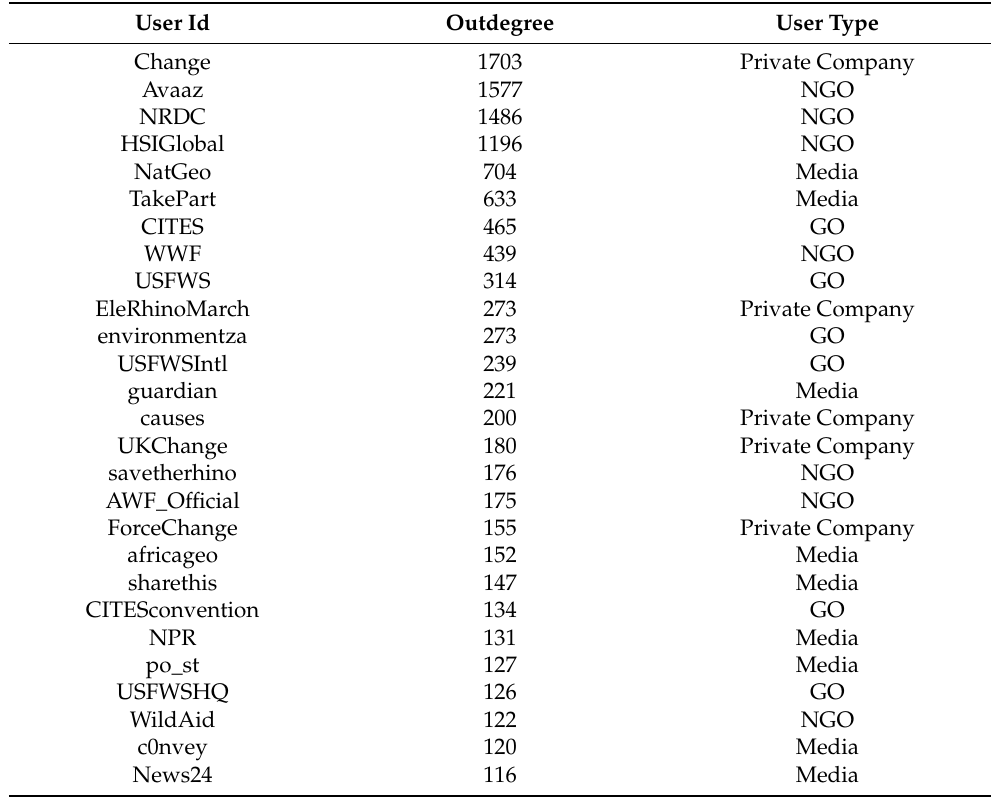
Table 3. Profile of the users with outdegree over 100.